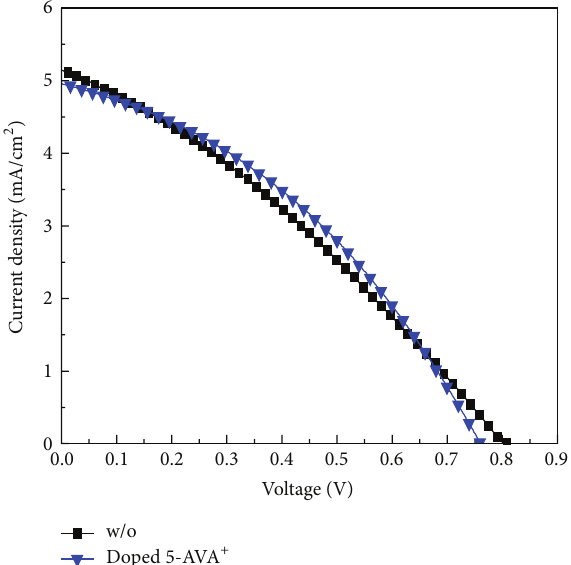
Figure 6: J - V characterization of the optimal PSCs with/without doping 5-AVA + .